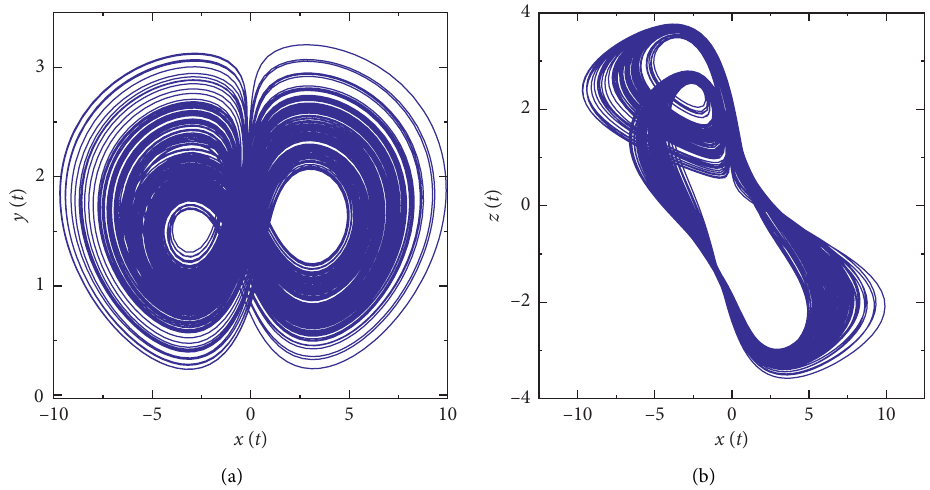
� 0 . 57 and q � q � 1 projected onto (a) the x − y phase plane and (b) the 1 2 3